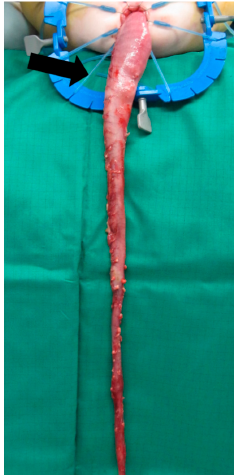
Figure 5. Mobilization of the colon is completed until the transition zone is developed transanally (arrow). Performing the anal anastomosis, the camera allows the control of the correct posi- tioning of the colon. The postoperative management and follow up are performed according to the guide- lines of ERNICA (European Reference Network for rare Inherited and Congenital (diges- tive and gastrointestinal) Anomalies) [1].